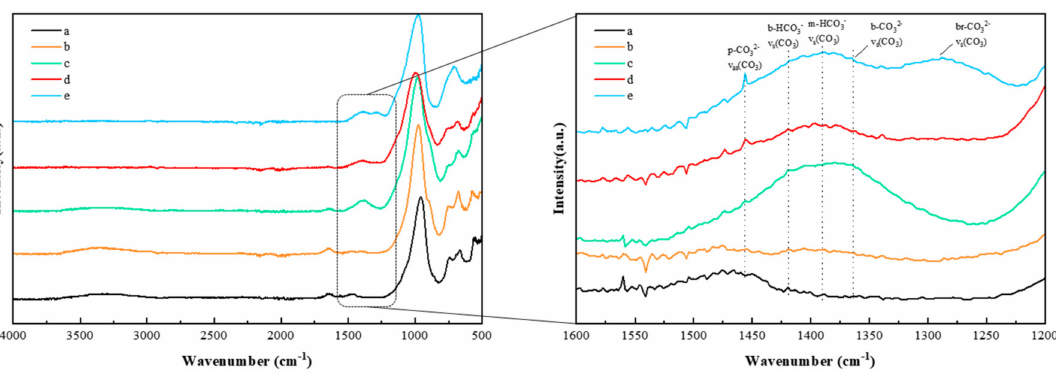
Figure 11. The infrared spectra of different adsorbents were as follows: (a) blank 13X, (b) fresh Zn-13X, (c) used Zn-13X, (d) regenerated Zn-13X and (e) used Zn-13X after regeneration. The FTIR results obtained at 1600–1200 cm − 1 indicate that the presence of CO 2 over Zn-13X adsorption leads to the formation of bicarbonate and carbonate species [33].